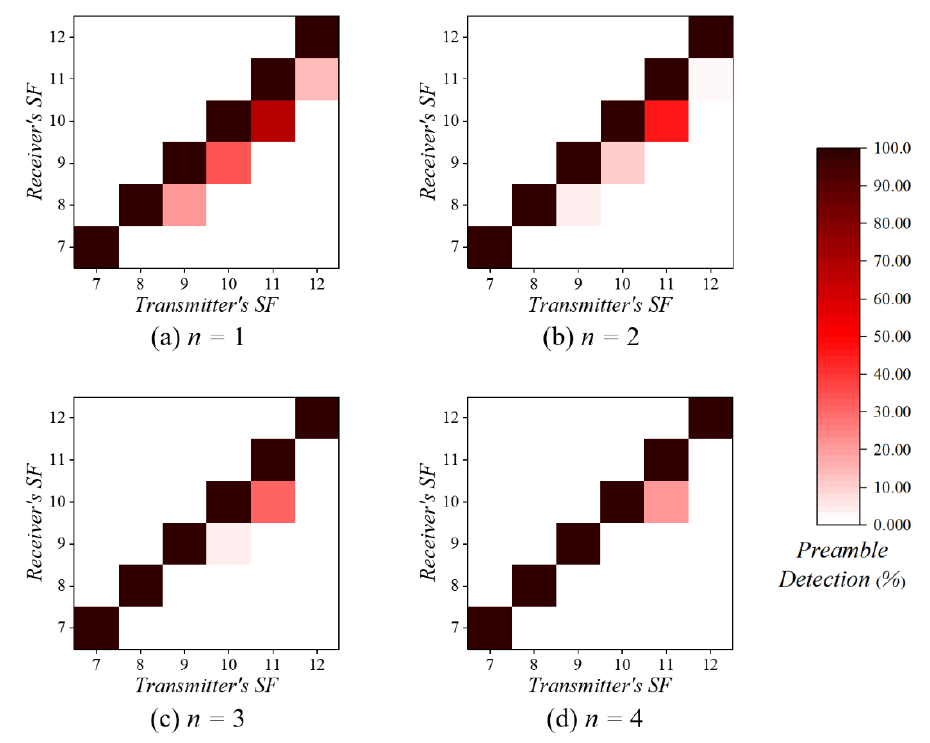
Figure 3. The probability of preamble detection according to the number of spreading factor (SF)